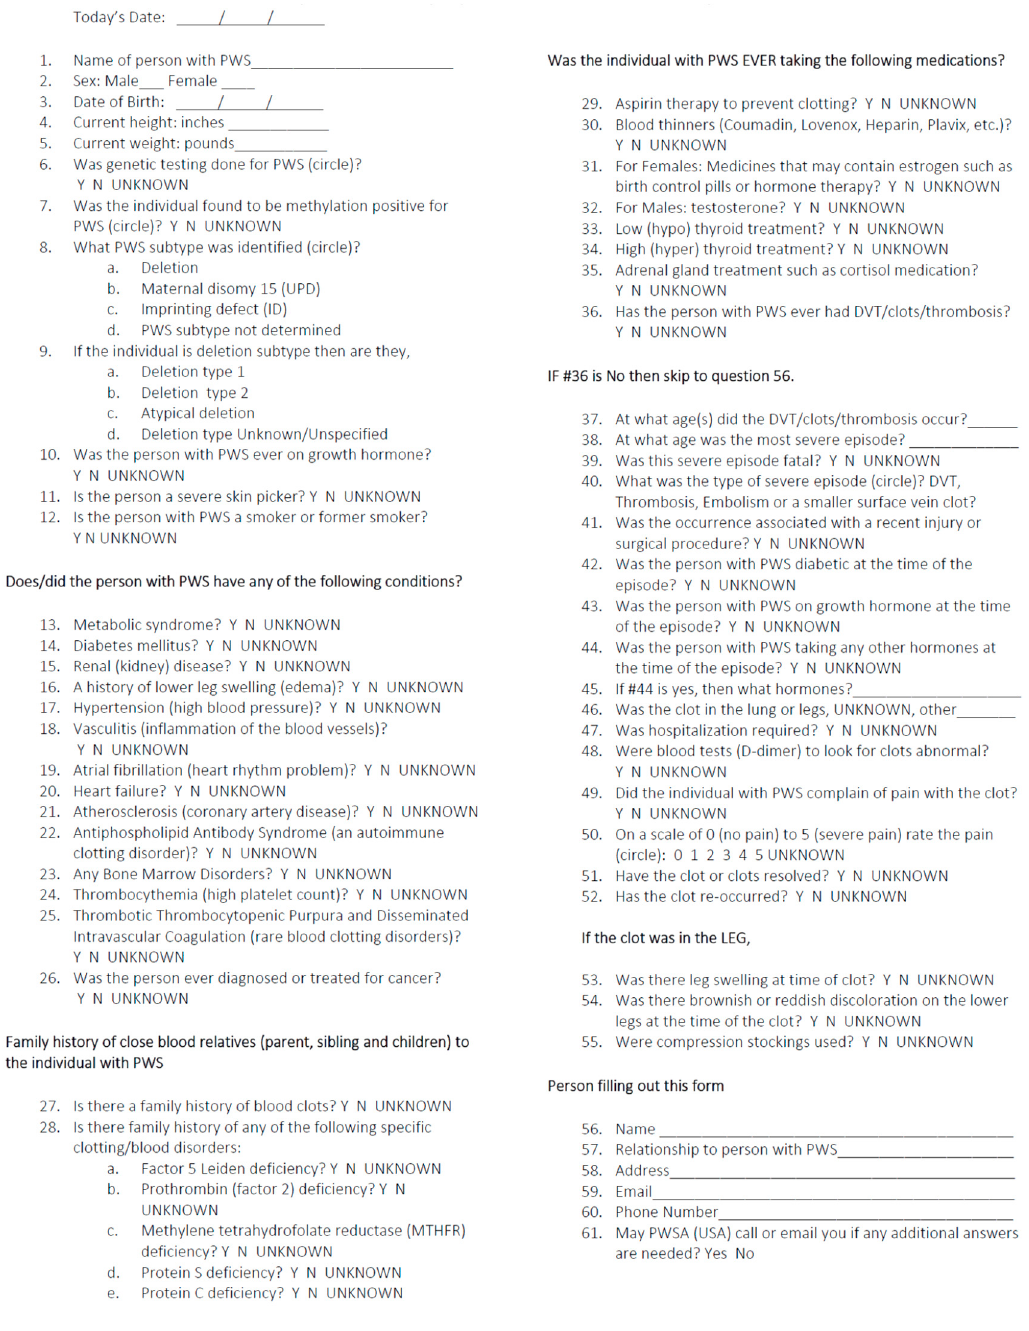
Figure 1. Vascular Blood Clots, Deep Vain Thrombosis and / or Thrombosis in Prader-Willi Syndrome Questionnaire.